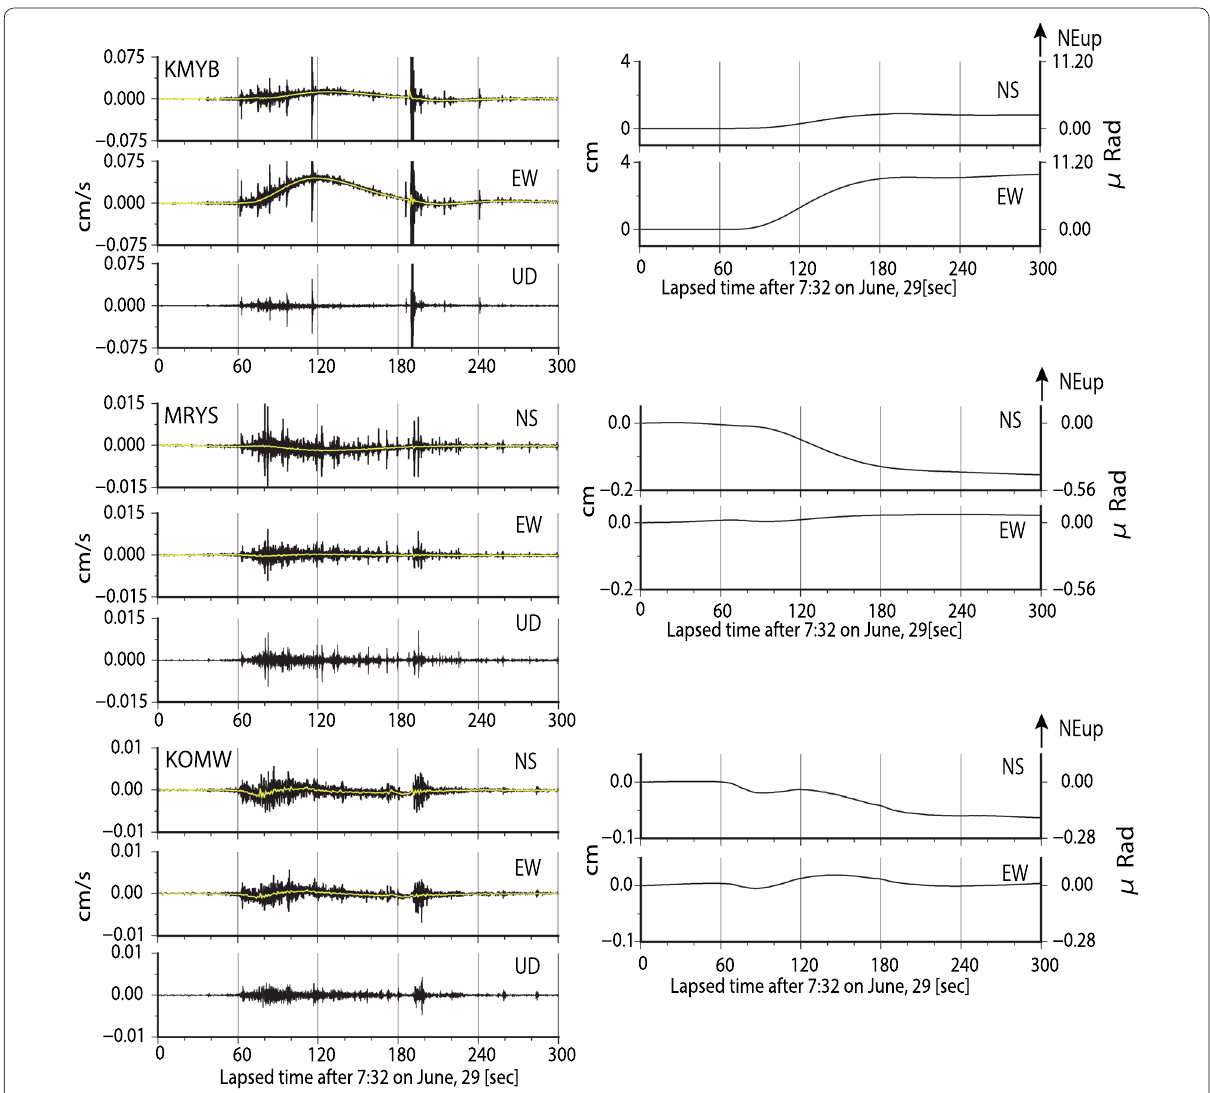
Fig. 4 Seismograms of broadband seismographs recorded on June 29, 2015. In the left column, the top, middle, and bottom three panels show the raw velocity seismograms recorded at KMYB, MRYS, and KOMW, respectively. The yellow lines on the horizontal components of the seismograms represent moving averages based on 1-s intervals. The integration records of the moving average of the horizontal components are shown in the right column. Since the integration records primarily consist of components with a period of 120 s or more, they are considered to represent tilt changes and are interpreted in the units on the y -axis right-hand side of the figure. The displacement components with periods shorter than 120 s are not clear and are interpreted in units on the y -axis on the left-hand